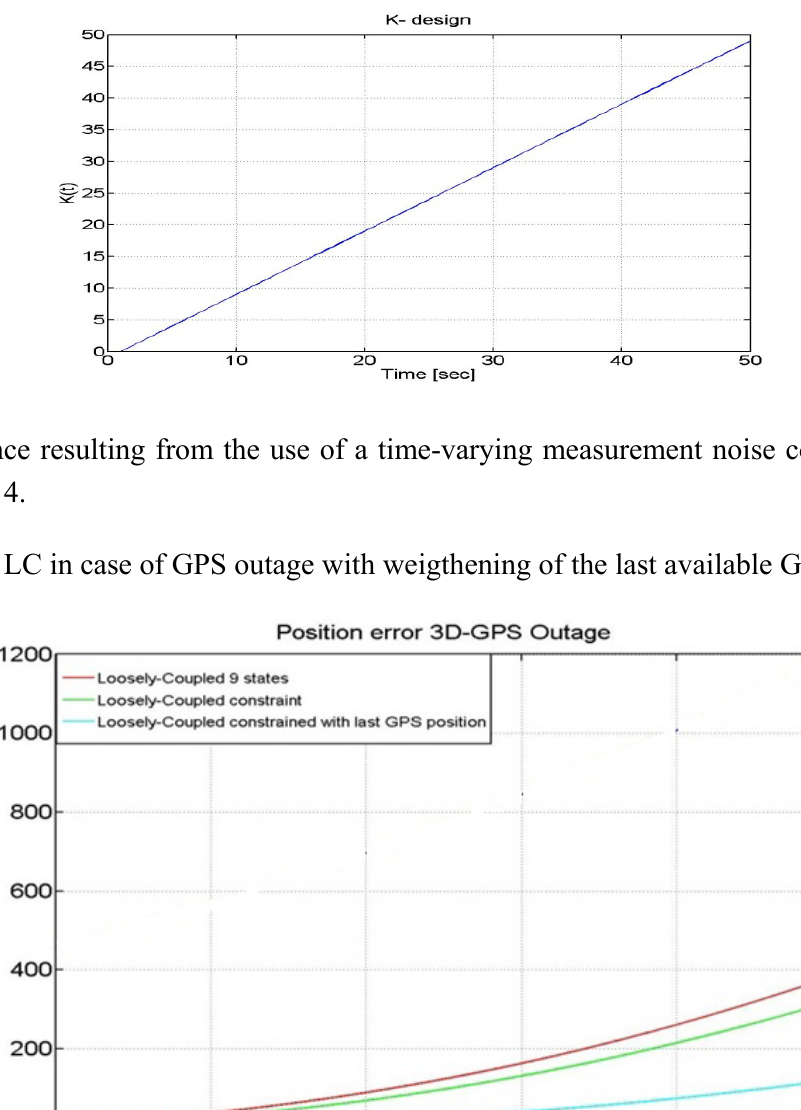
Figure 13. K(t) linear profile.